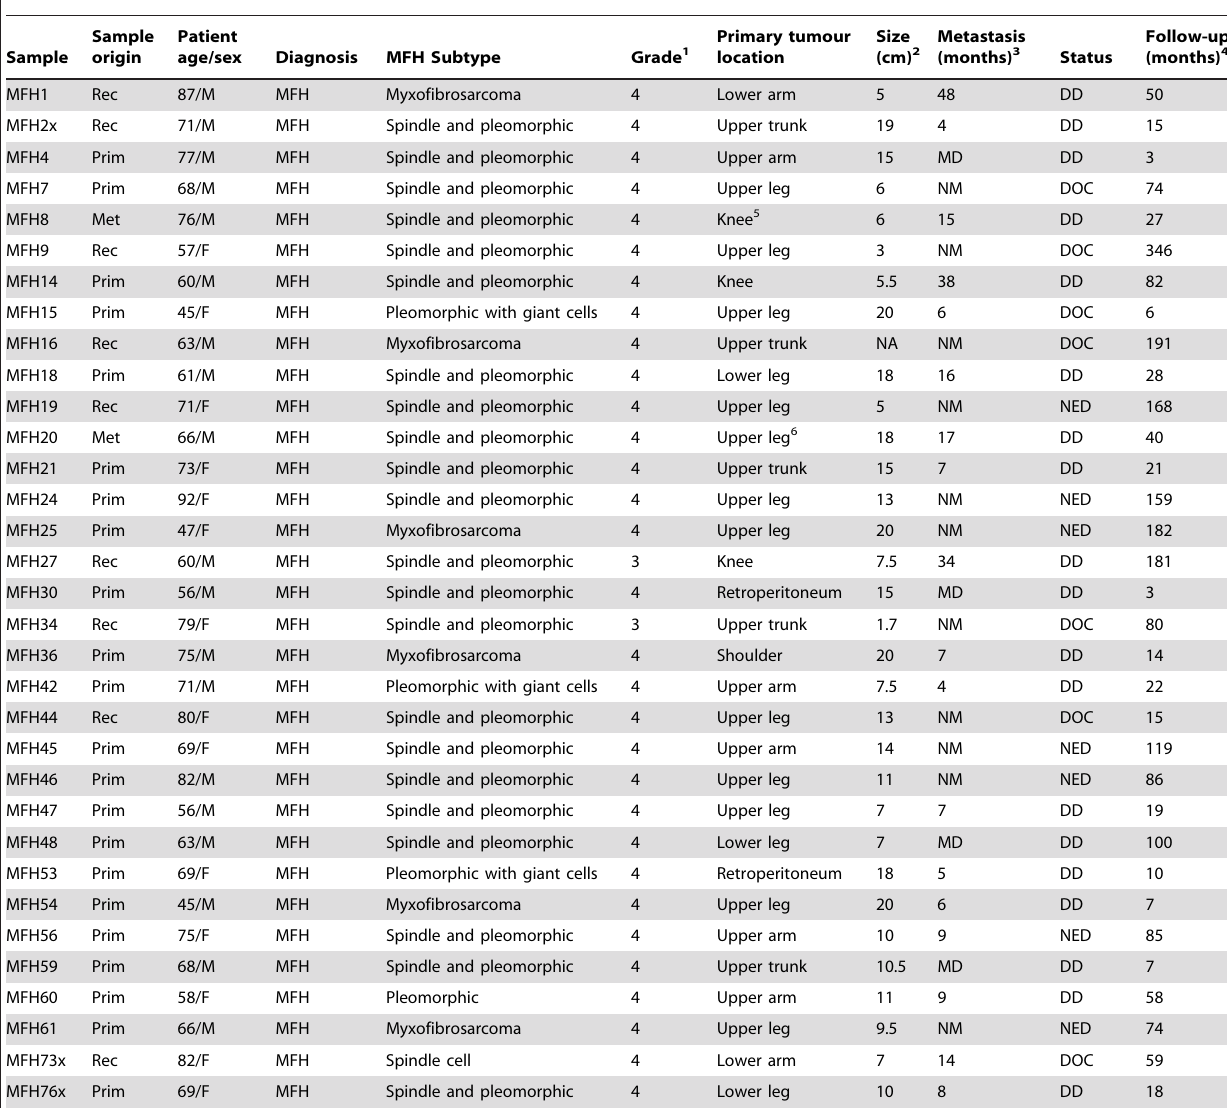
Table 1. Clinical data of malignant fibrous histiocytomas.